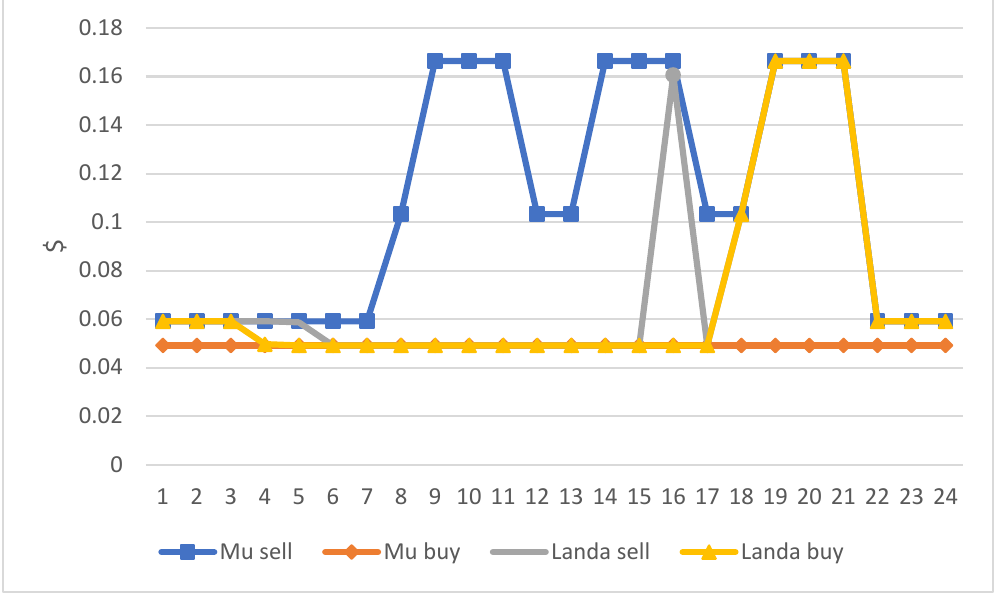
Figure 15. Change in the prices of buying and selling energy inside microgrid with microgrid clusters and an upstream network. Figure 16 represents the changes in the energy sale price of each of the microgrids to consumers in a 24 h period.